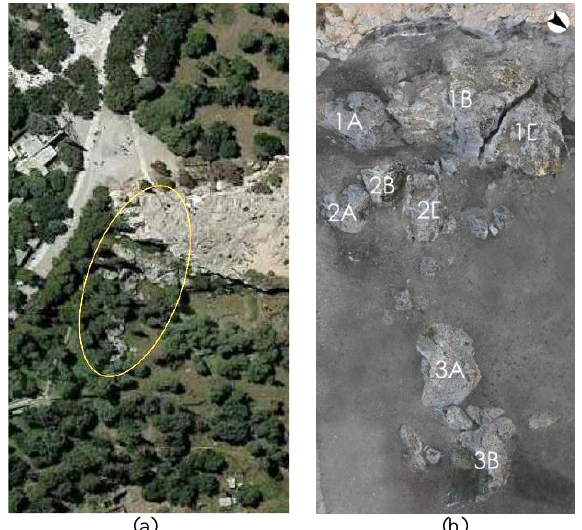
Figure 1: The collapsed peak of the hill. (a) Aerial photograph, (b) Ground plan orthoimage of the investigated area. Additionally, the limestone is seated on a layer of schist, which is corroded more rapidly than limestone. As a result, as centuries passed by, schist ‘shrunk' towards the center of the hill and the limestone formed cantilevers a few meters above the ground level that gradually